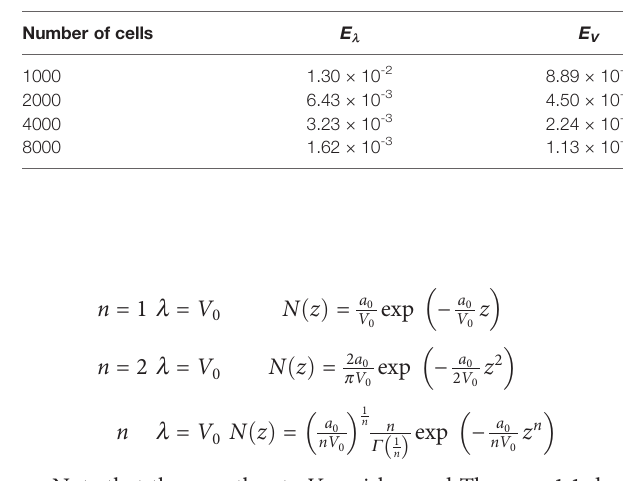
TABLE 6 | Uniform fragmentation, ex. 1: errors for several number of grid points.